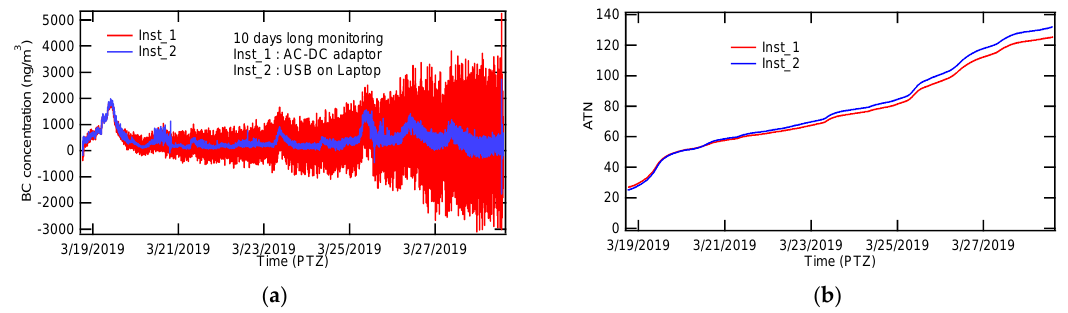
Figure 5. Noise is intensified when instrument is connected to an AC-DC adaptor. ( a ) black carbon (BC) concentration, ( b ) time series of attenuation (ATN) values.